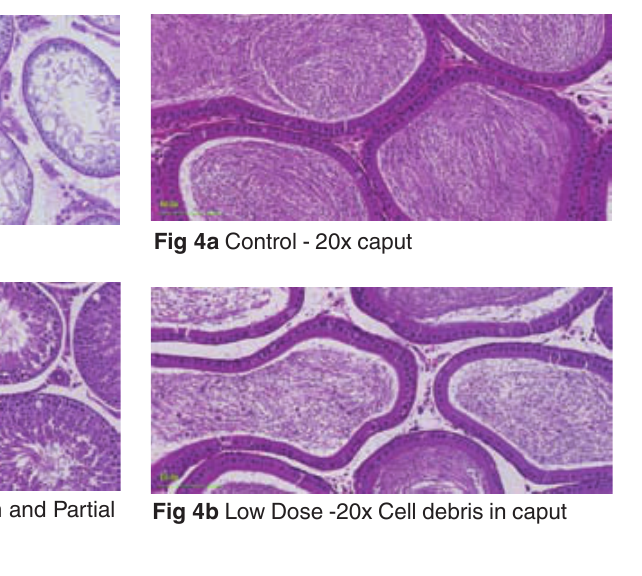
Fig 3 Mid Dose - 30x Spermatid Retention